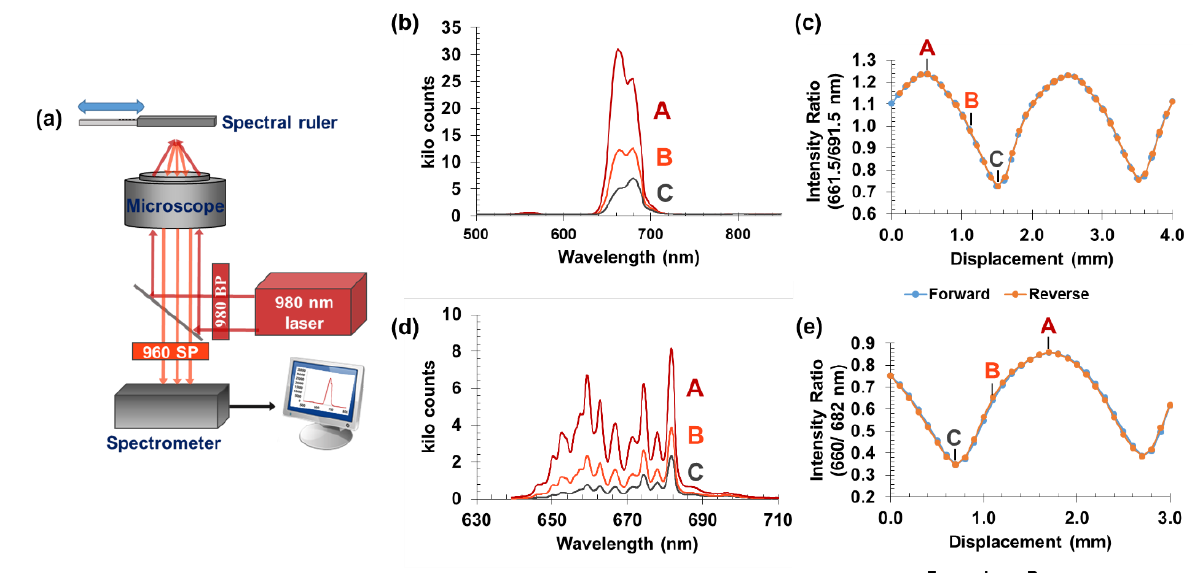
Figure 4. ( a ) Experimental set-up schematic. The spectral ruler is attached to a motorized stage and positioned above the microscope objective. The sample is excited from below with a 980 nm laser, and the luminescent signal generated is captured by a spectrograph with a 0.30 s exposure time. ( b ) Luminescent spectra acquired using a low-resolution 150 line/mm grating at three distinct encoder positions, which are labeled A (with no BG dye observed through the mask), B (intermediate position), and C (maximum BG dye observed through mask). ( c ) The 661.5/691.5 nm spectral ratio versus encoder position, including the labeled positions corresponding to A, B, and C in ( b ). ( d ) High-resolution spectra with 1200 line/mm grating at three distinct encoder positions, which are labeled A (with no BG dye observed through the mask), B (intermediate position), and C (maximum BG dye observed through mask). ( e ) The 661/682 nm spectral ratio versus encoder position, including the labeled positions corresponding to A, B, and C in ( d ). Backlash correction for ( c , e ) are shown in Figure S1.